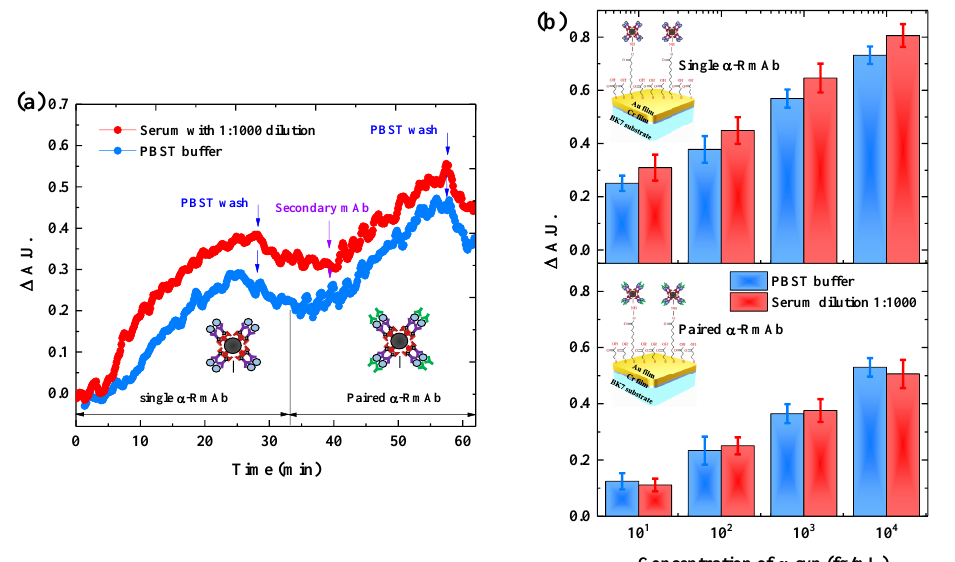
Figure 4. ( a ) Representative SPR sensorgram illustrating the real-time immunoassay of α -syn with a concentration of 10fg/mL in PBST buffer (blue line) and diluted serum buffer (red line), which involving two detection scenarios: single antibody and paired antibody. ( b ) Correlation of SPR signal with a series concentration of α -syn in PBST buffer (blue color bar) and diluted serum buffer (red color bar) by using the single antibody (upper panel) and the paired antibody (lower panel). The error bar represents the standard deviation of the three replicated measurements.